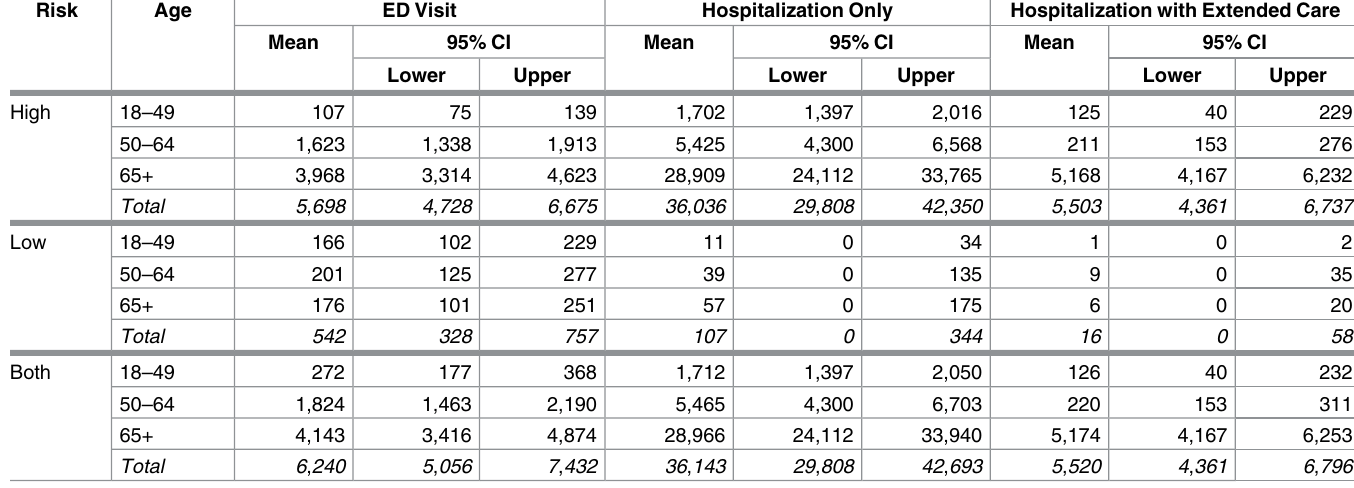
Table 9. Annual estimates of influenza-attributed direct medical costs for healthcare encounters by risk and age group in thousands of US Dollars averagedover five respiratory seasons. Risk Age ED Visit